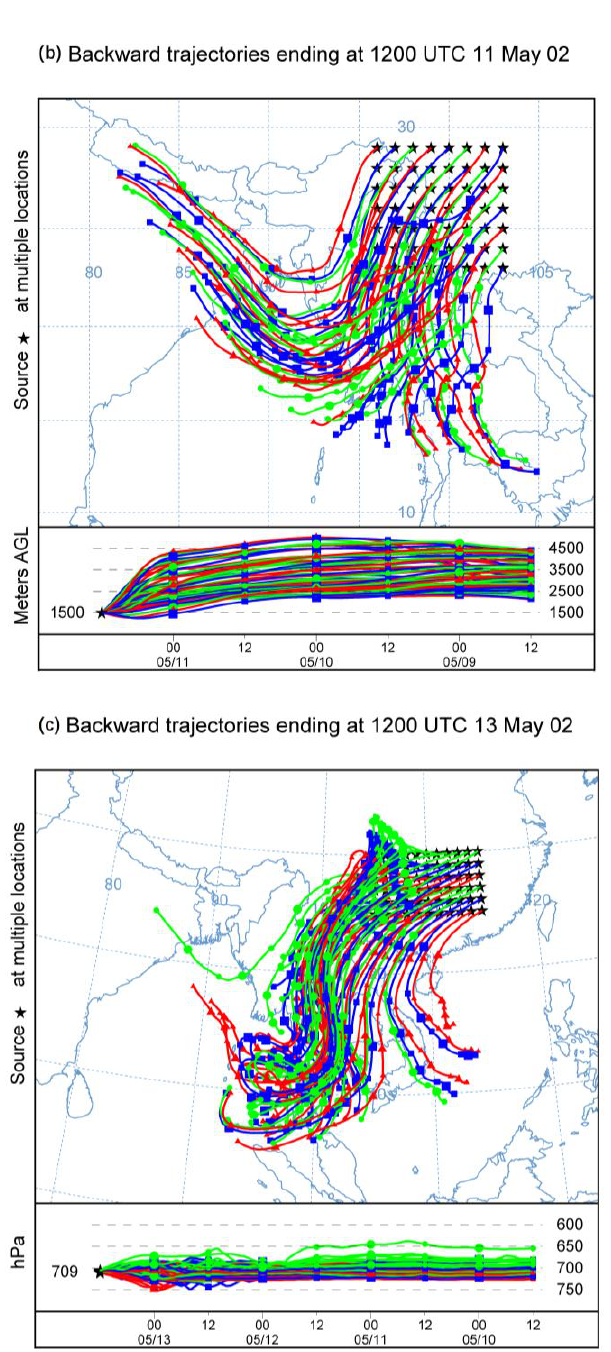
Figure 6. Air particle transport trajectories calculated by the HISPLIT model. (a) 120-h forward tracing trajectories originating from near the tropical cyclone (5–15 ◦ N, 90–100 ◦ E) in the Bay of Bengal trajectories originating from near the tropical cyclone (5 – 15° N, 90 – 100° E) in the Bay of Bengal starting at 06:00 on 9 May 2002 and 3000 m height above the surface. ( b ) 72-h backward tracing trajectories originating from the region of heavy rainfall in southwestern China (23 – 29° N, 96 – 103° E) starting at 12:00 on 11 May 2002 and 1500 m height above the surface. (c) 96-h backward tracing trajectories